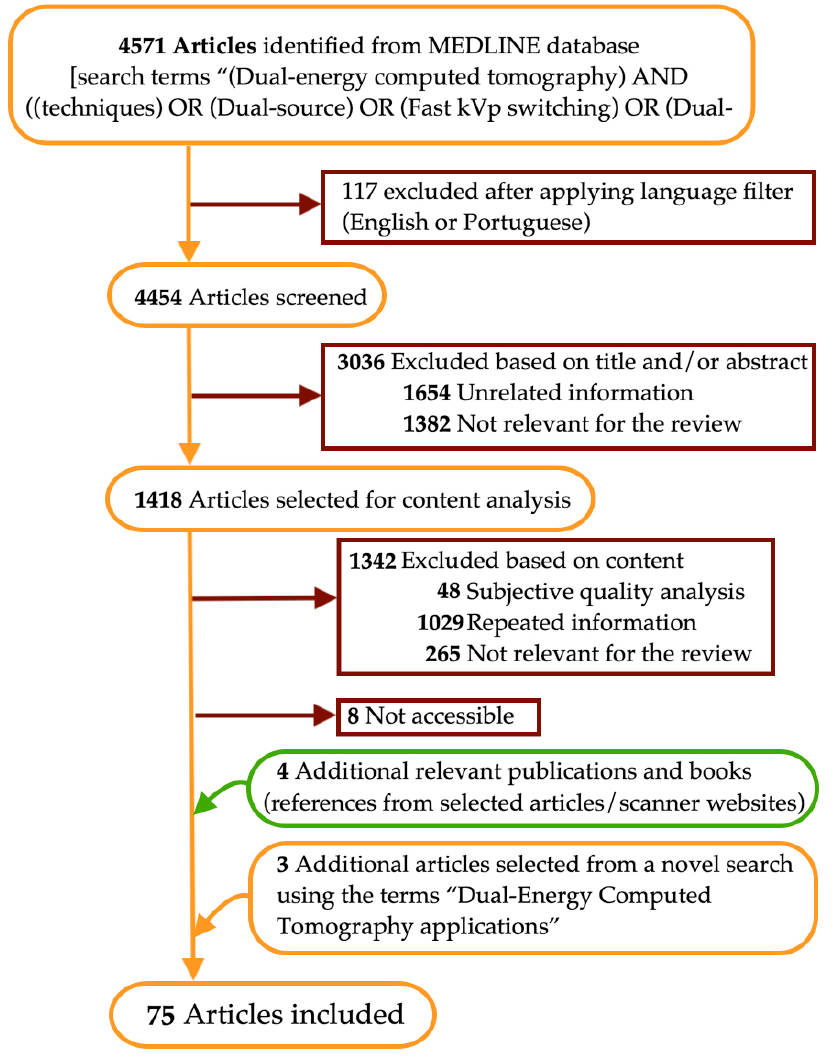
Figure 1. Flow diagram of the narrative review of the literature.